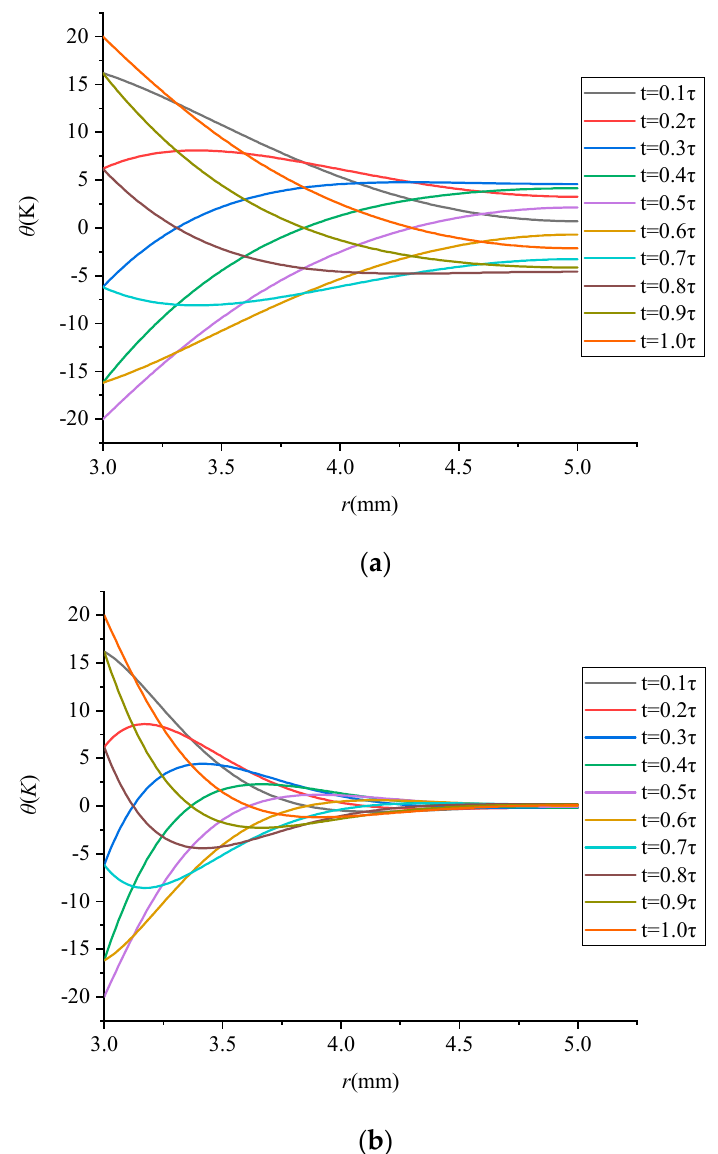
Figure 6. The distribution of θ – r temperature in wall thickness ( a ) tube made from aluminum alloy, r 1 = 3 mm, r 2 = 5 mm, f = 30 Hz ( b ) tube made from carbon fiber, r 1 = 3 mm, r 2 = 5 mm, f = 30 Hz.